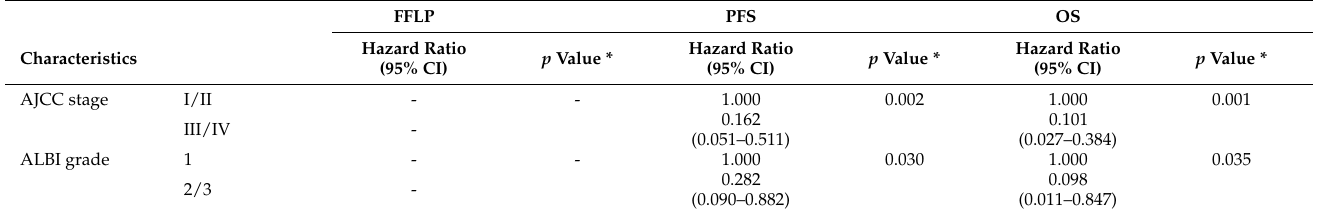
Table 3. Multivariate analysis of pretreatment characteristics associated with freedom from local progression (FFLP), progression-free survival (PFS), and overall survival